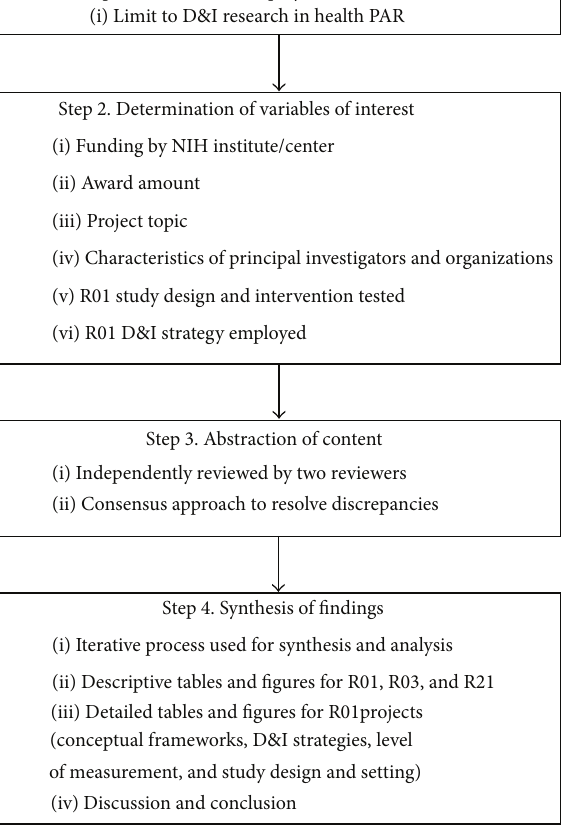
Figure 1: Flowchart for the review process. PAR: Program Announcement Reviewed; D&I: Dissemination and Implementa-